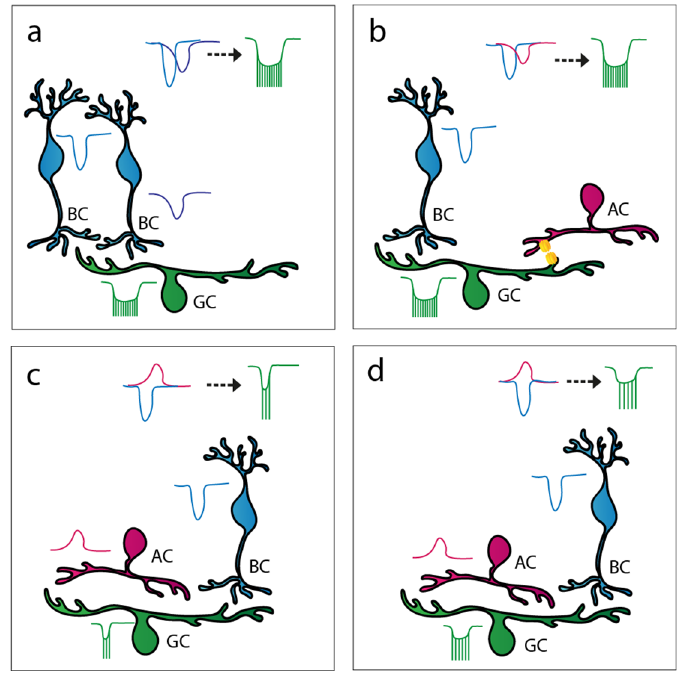
Figure 9. Summary of potential signal summation mechanisms affecting RGC response transience.